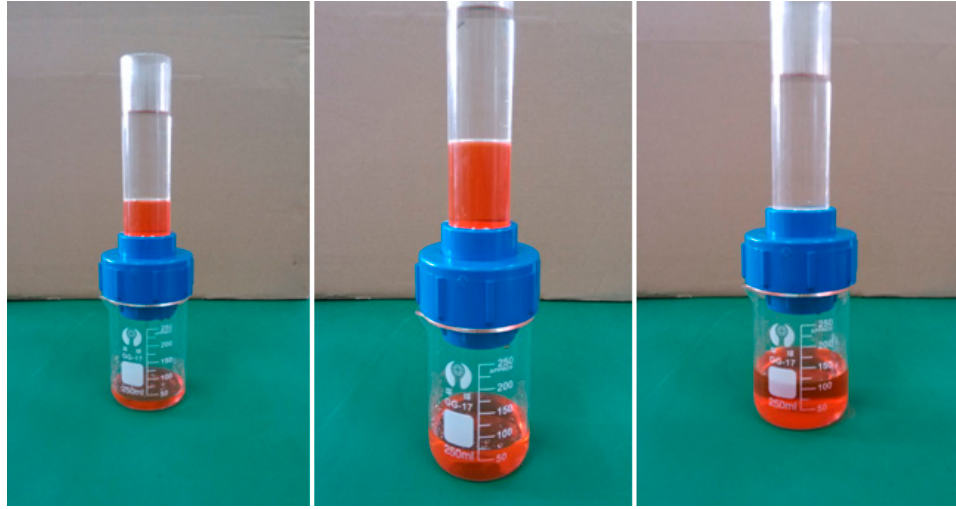
Figure 9. Oil–water separation experiment performed using the hybrid-coated mesh.